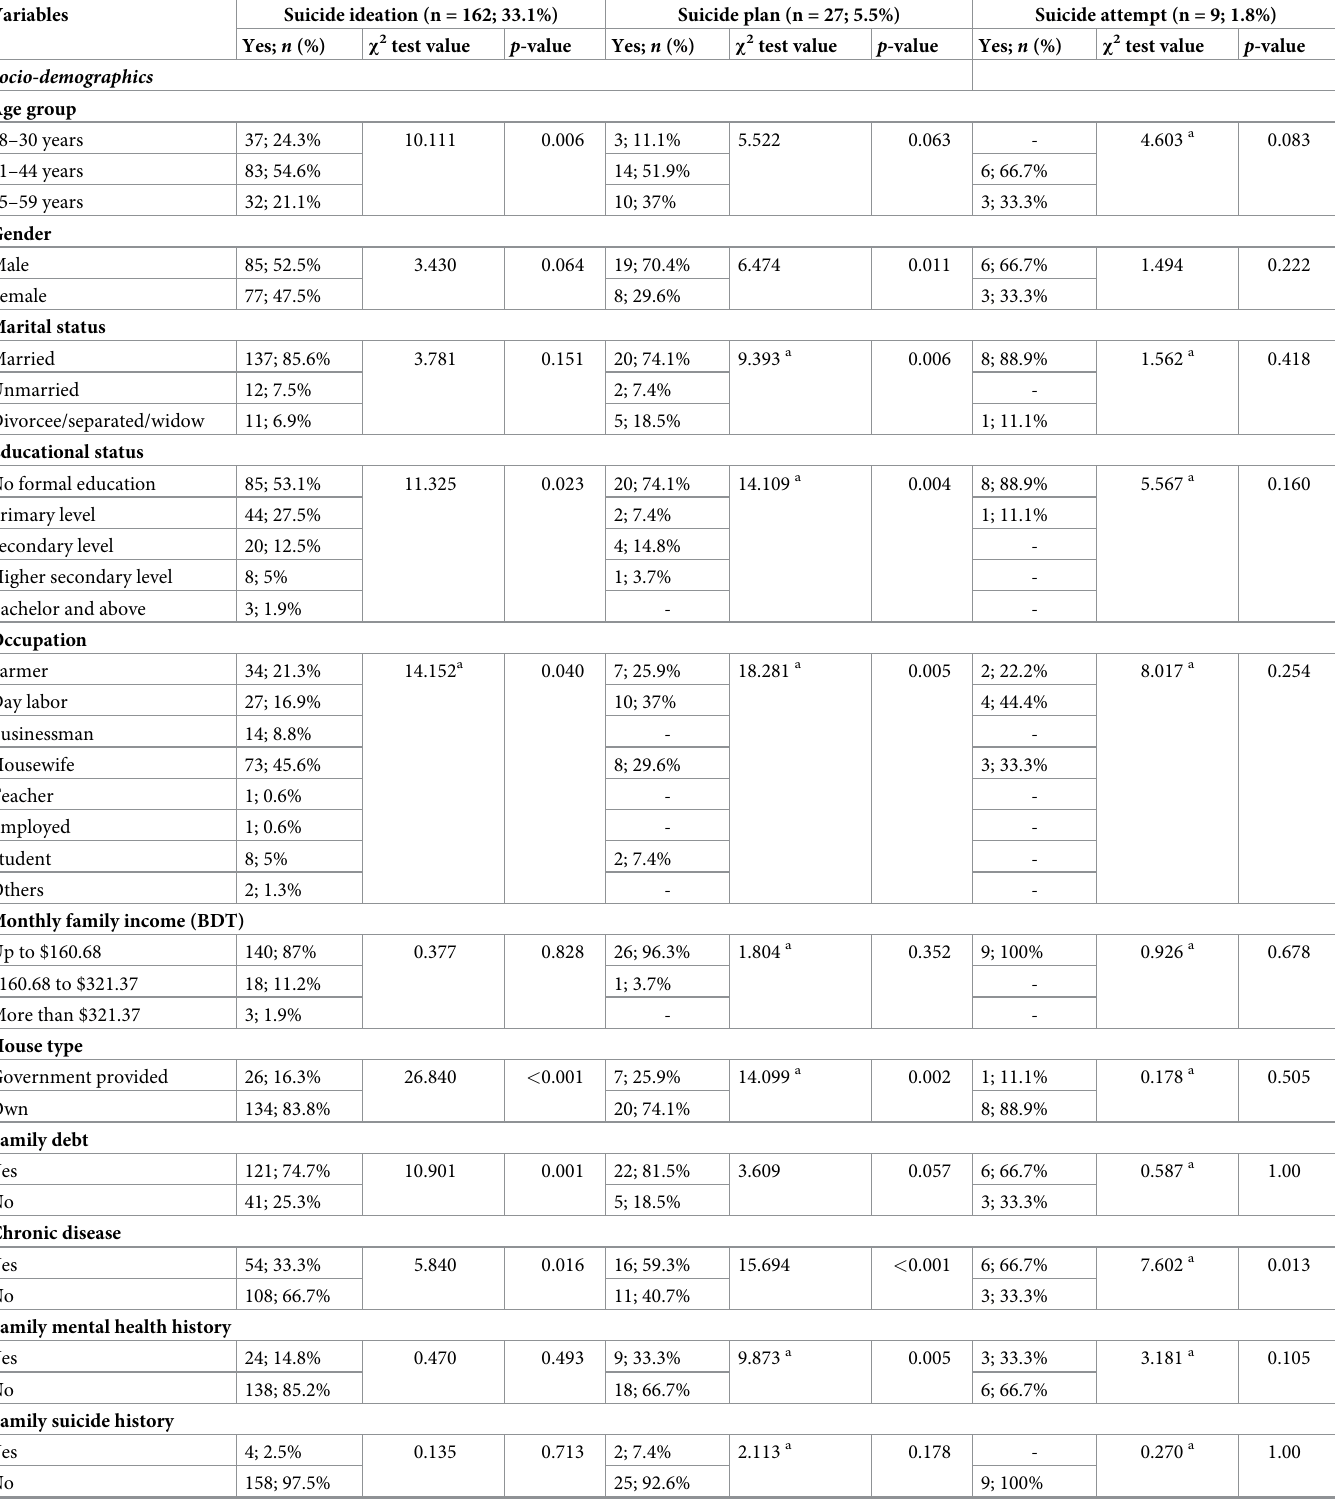
Table 2. Association between the study variables and lifetime suicidal behaviors.